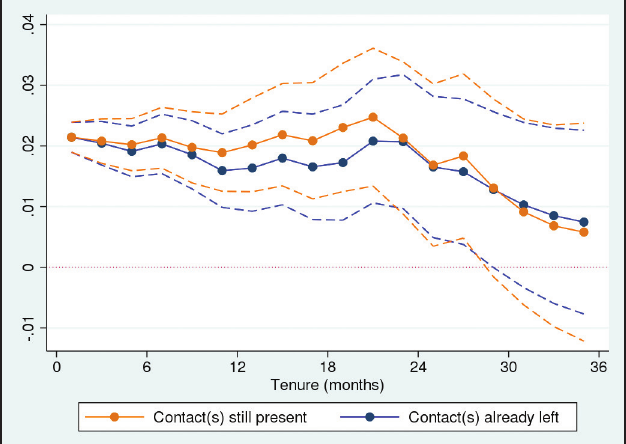
Figure 1 Wage-tenure profiles and referrer